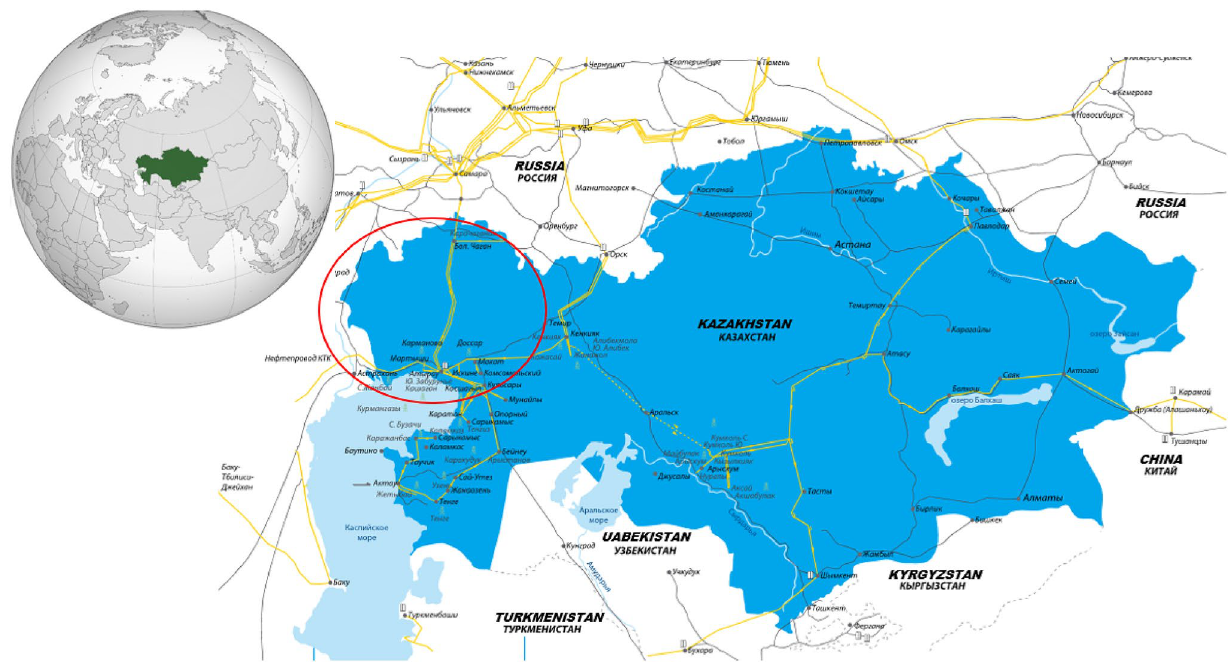
Fig. 1 Location map of the Pre-Caspian Sedimentary Basin, West Kazakhstan and neighboring CIS countries (modified from KMG